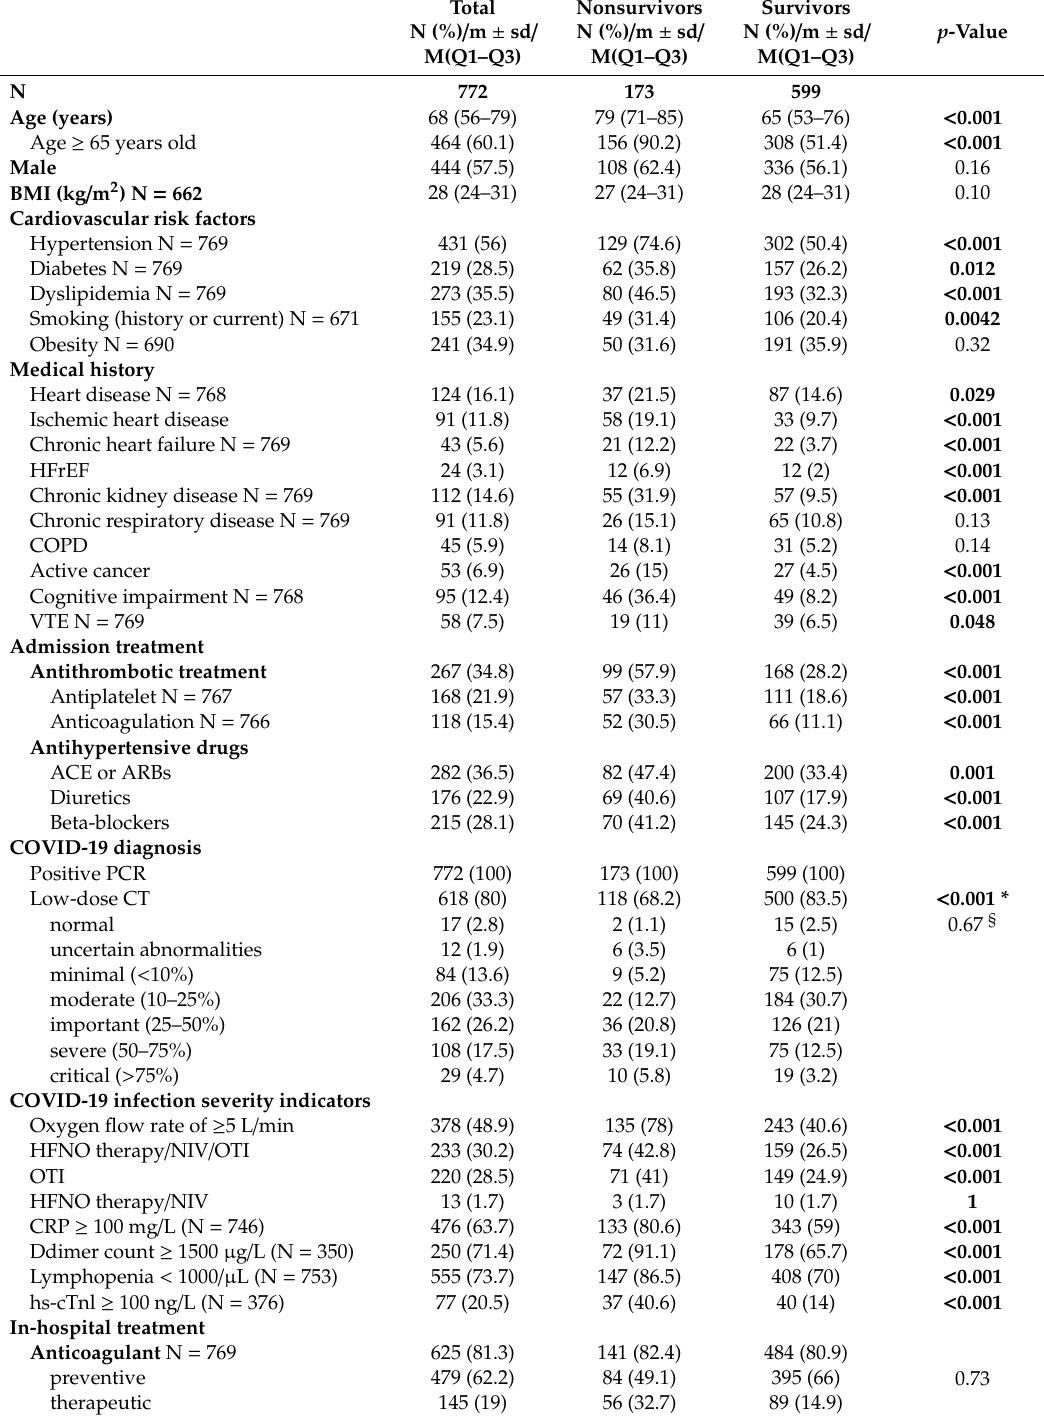
Table 3. Demographic, clinical, and paraclinical characteristics of the study population according to vital status at